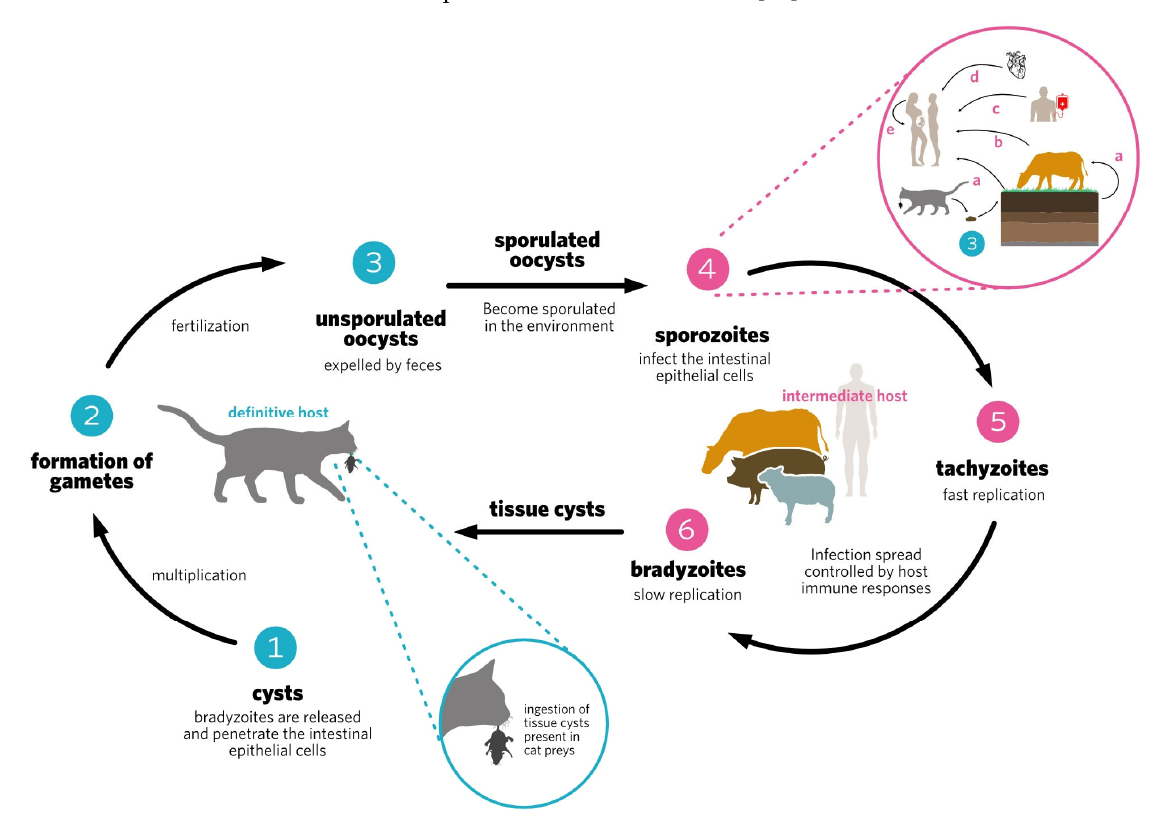
Figure 1. Life cycle of Toxoplasma gondii . 1—Consumption of meat containing cysts by the definitive host (Felidae), followed by the release of bradyzoites, and infection of intestinal epithelial cells; 2—After intense multiplication, gametes are formed; 3—After fertilization, unsporulated oocysts are released in the feces of the definitive host; 4—Intermediate hosts are infected by diverse means, such as by the ingestion of sporulated oocysts ( a ) and consequently the sporozoites infect the intestinal cells; 5—Conversion of sporozoites into tachyzoites, the rapidly multiplying form; and 6—Host immune responses contribute to the conversion of tachyzoites into bradyzoites, constituting cysts, a slowly replicating form. There are several pathways of intermediate host transmission: ( a ) ingestion of oocysts present in water, vegetables, or fruits; ( b ) ingestion of tissue cysts present in undercooked meat; ( c ) infection with tachyzoites by blood transfusion; ( d ) infection with cysts through tissue transplantation; and by ( e ) vertical transmission.